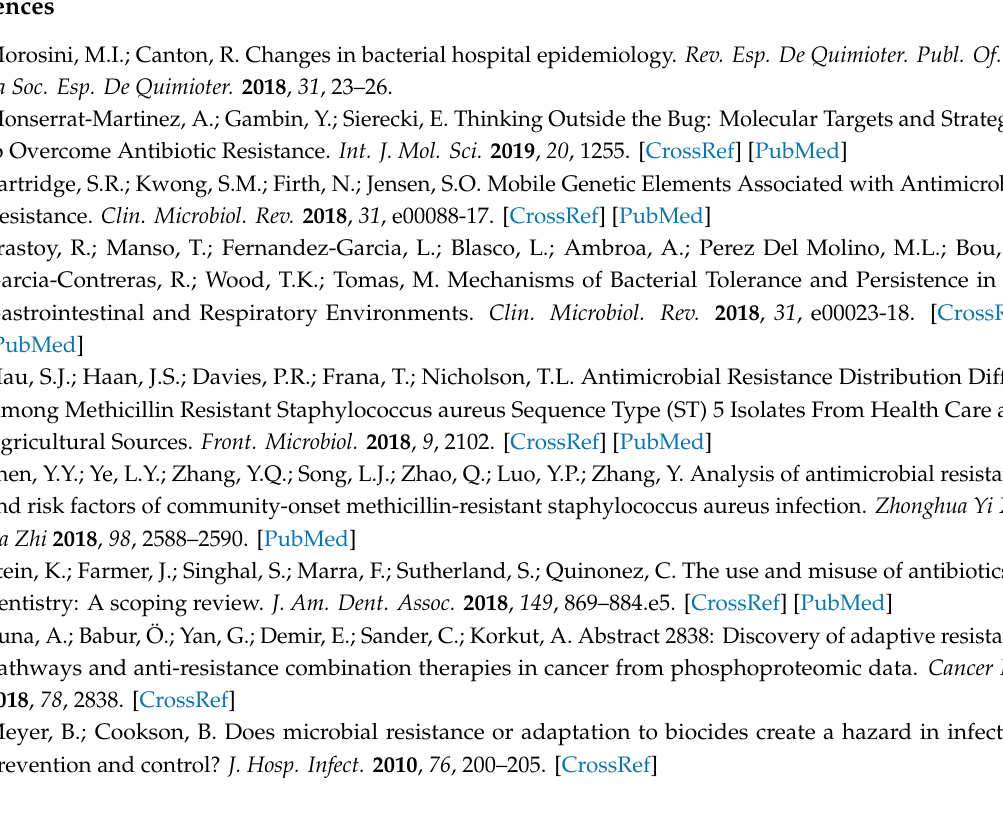
Table S1: Susceptibility Profile of Staphylococcus aureus 432170 isolated from diabetic foot ulcer of a patient with type 2 diabetes